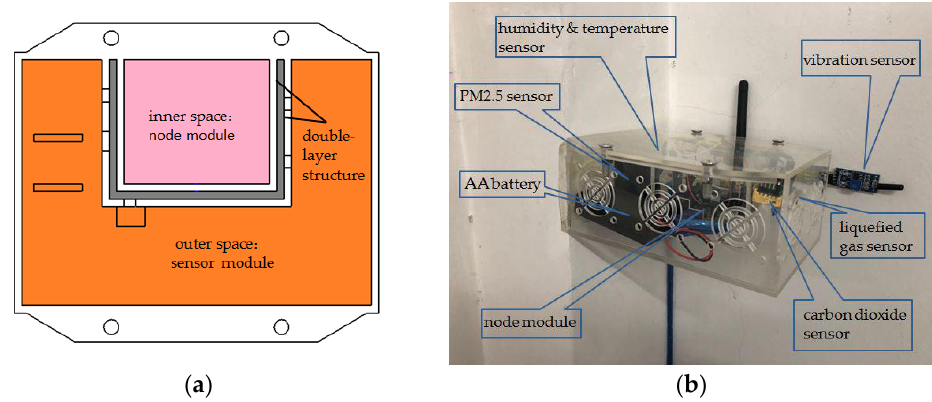
Figure 6. The design of indoor node package box: ( a ) schematic of the structure; ( b ) picture of the real product.